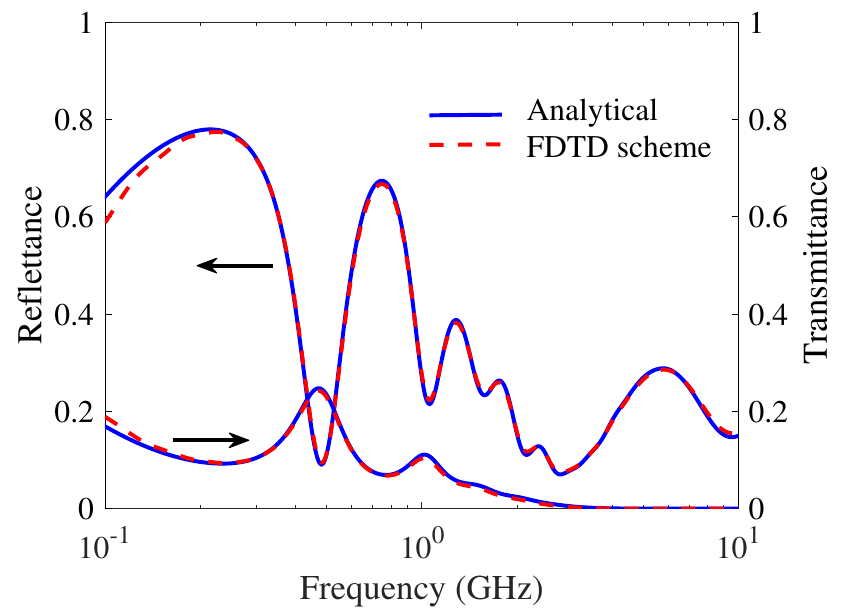
Figure 3. Reflectance and transmittance of the three-layer dielectric slab as a function of